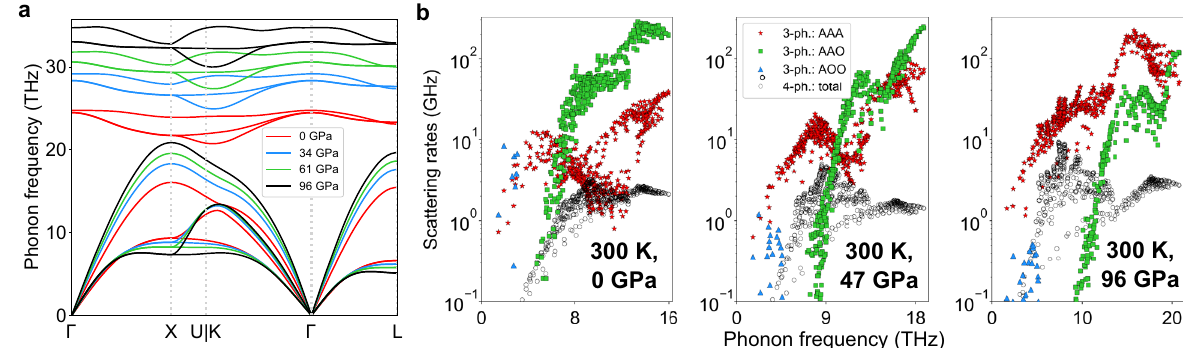
Fig. 2 Phonon dispersions and phonon – phonon scattering rates of BP vs. pressure. a Phonon dispersions of BP at different values of P . b Process-wise three-phonon and total four-phonon scattering rates for BP at RT and different pressures. Since acoustic phonons carry the majority of the heat, only their frequency bandwidth